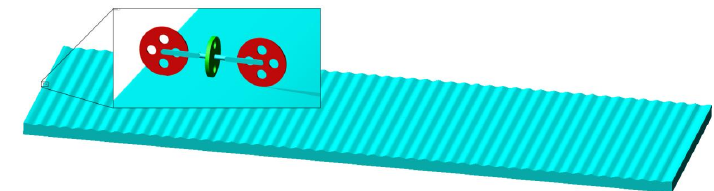
Figure 7. RWBR on the curved pavement in MSC